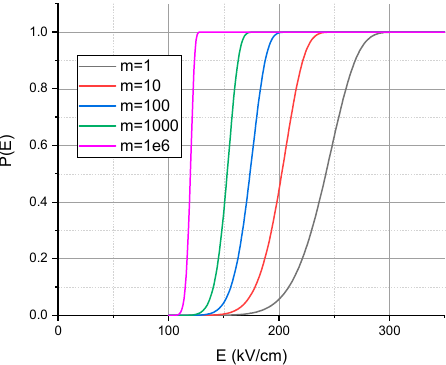
Figure 4. Example of Weibull distributions for increasing number of protrusions m . In this example, E 63 = 250 kV/cm, E 0 = 100 kV/cm, γ = 7 was chosen arbitrarily.